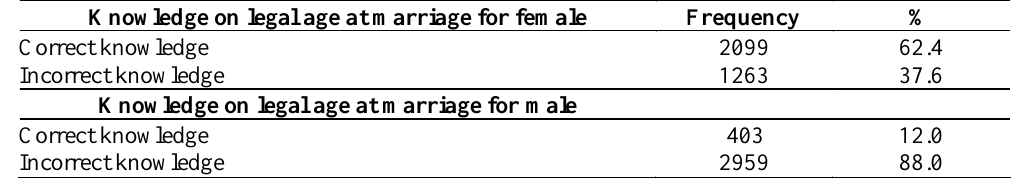
Table VI : Correlates of adolescent’s attitude towards early marriage: Multivariate analysis Independent